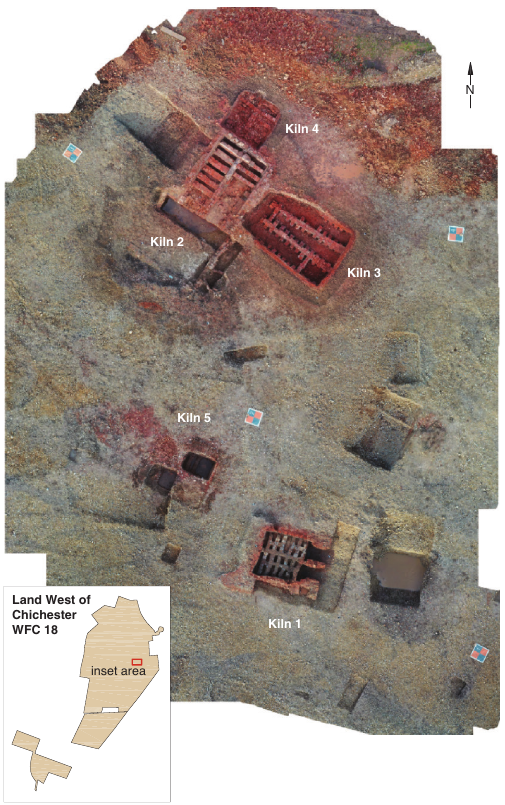
Figure 2 Aerial photo of Whitehouse Farm kilns taken during Archaeology South-East’s excavations in 2019 (Source: Archaeology South-East)